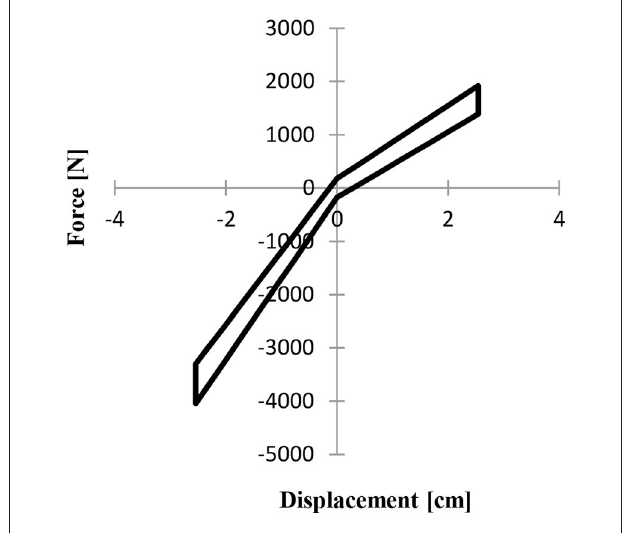
FIGURE 2 | Force displacement plot for the bi-linear liquid spring seal friction is illustrated with experimental